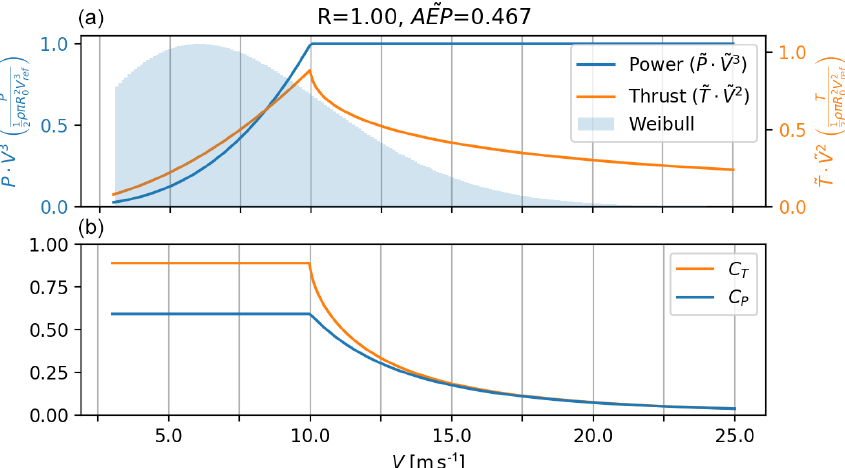
Figure 2. (a) The dimensionless power and thrust for the baseline rotor as a function of wind speed. Overlaid (in blue) is the Weibull wind speed frequency distribution used throughout (IEC-class III: V avg = 7 . 5; k = 2). (b) C T and C P as a functions of wind speed. These curves reflect how most turbines are operated today, targeting the maximum power coefficient below the rated power, which leads to a thrust peak just before the rated